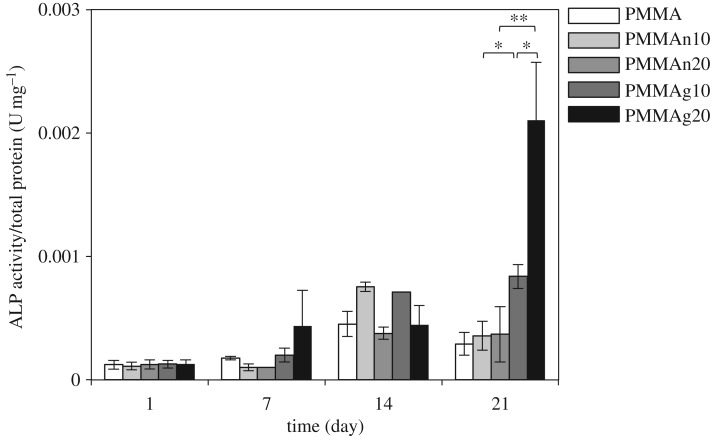
ALP activity of cells on composites. ALP activity increased with time. PMMAg10 and PMMAg20 showed greater ALP activity than PMMAn10 and PMMAn20 on day 21. Error bars show standard deviation. *p < 0.05, **p < 0.01.